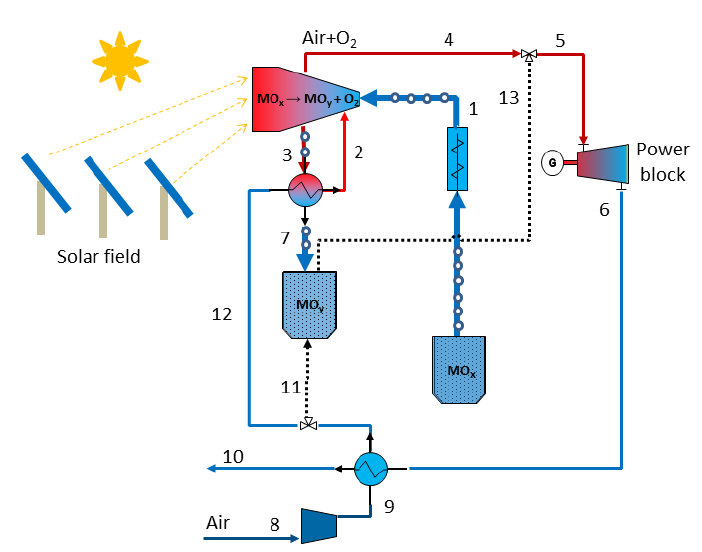
Figure 13. Integration scheme for a central tower plant/TCS unit (oxide systems)/power block; on-sun operation assuming a directly irradiated reactor.